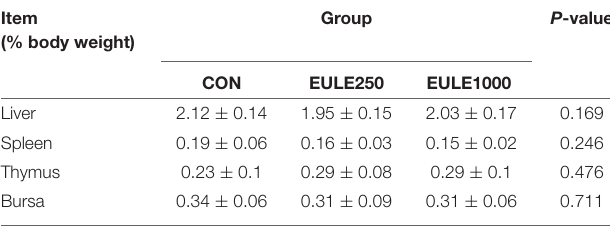
TABLE 6 | Effects of EULEs on organ indices in